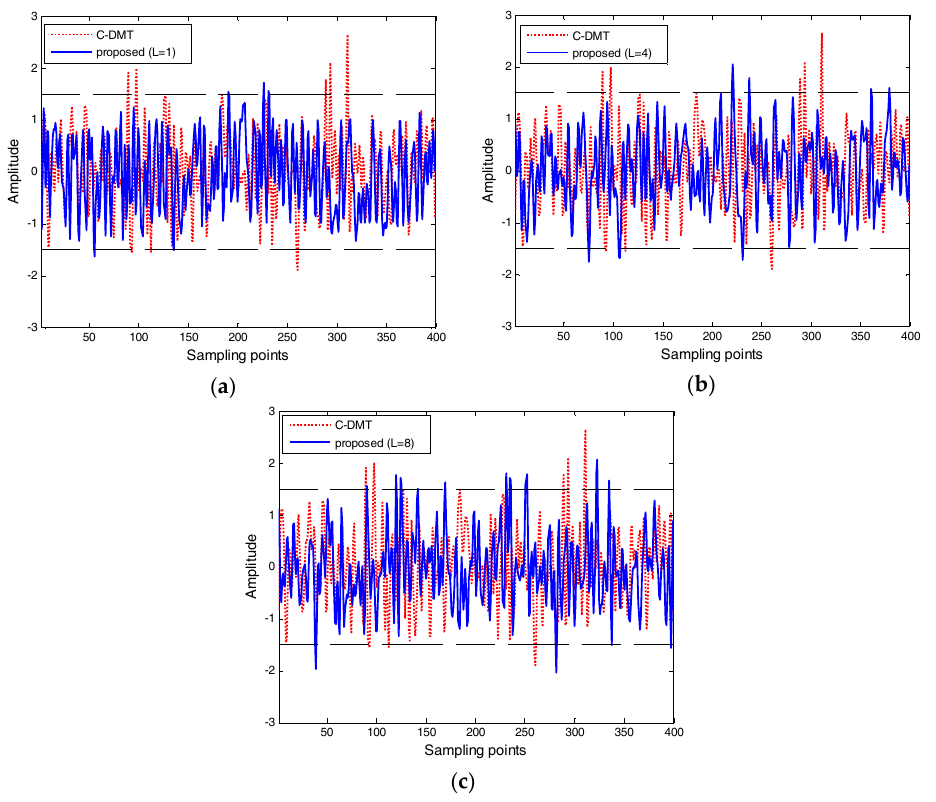
Figure 5. Waveforms of proposed scheme with various numbers of split bands: ( a ) L = 1 ( b ) L = 4 ( c ) L = 8.